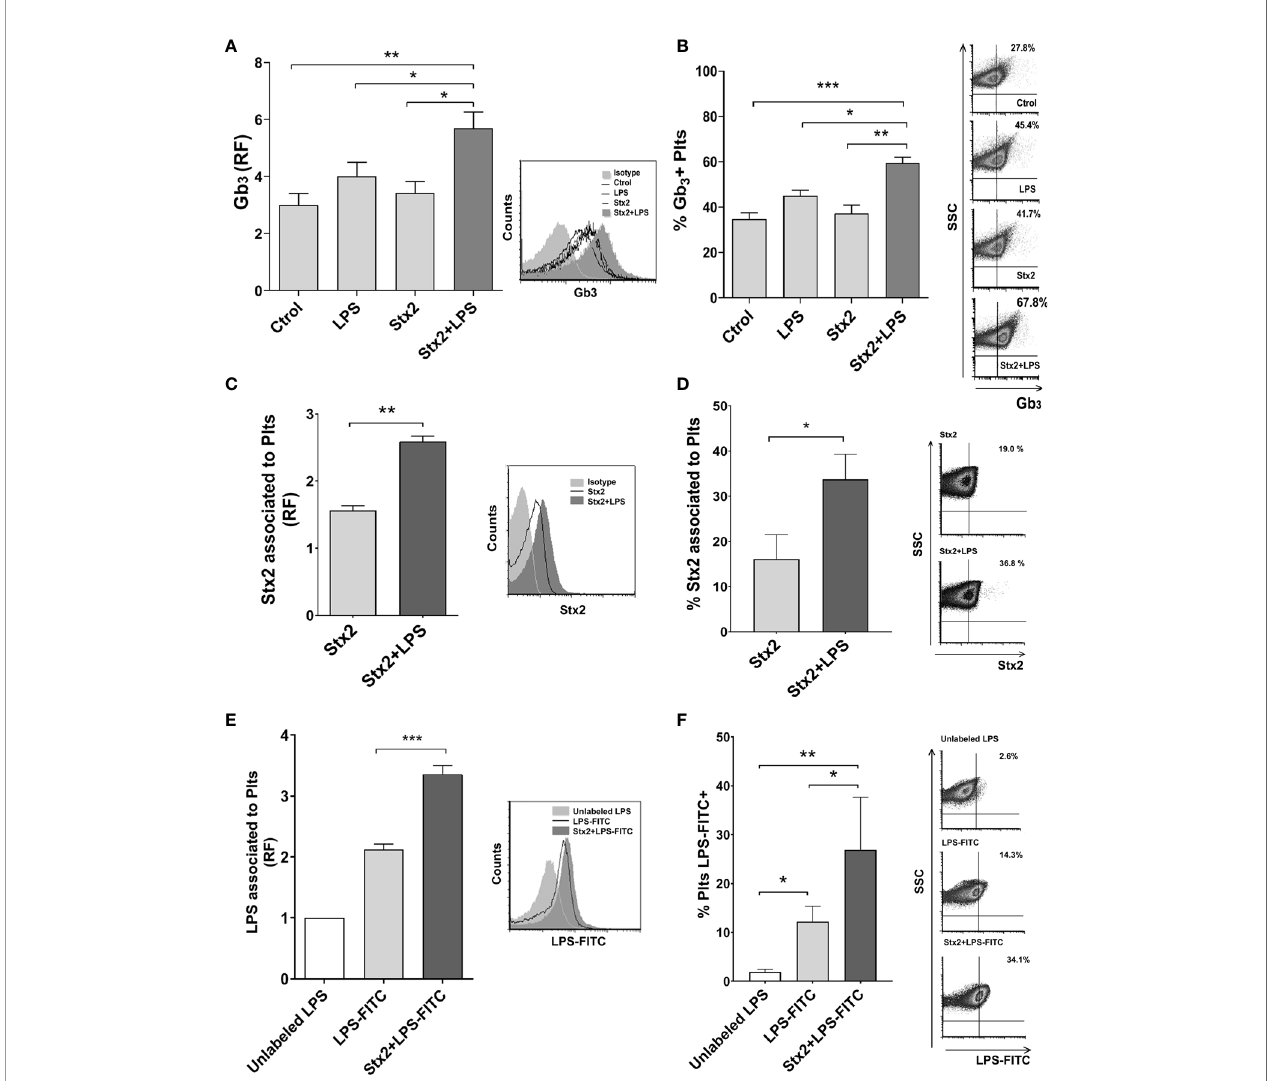
FIGURE 2 | Stx2 and LPS treatment increased Gb 3 expression and binding of Stx2 and LPS to Plts. Isolated Plts were left untreated (Ctrol) or treated with Stx2 (20 ng ml − 1 ) for 20 min before addition or not of LPS (0.3 µg ml − 1 ) for another 20 min (LPS or Stx2+LPS). Evaluation of Gb 3 expression (A) and the percentage (%) of Gb 3 expressing Plts (B) was performed by fl ow cytometry analysis. (A) Gb 3 expression was expressed as the relative fl uorescence (RF) of the mean fl uorescence intensity (MFI) obtained on treated samples compared to isotype control. Histogram plots from one representative experiment are presented (right). (n = 4). (B) Percentage (%) of Gb 3 expressing Plts. Density plots from one representative experiment are presented (right). (n = 4). (C) Stx2 association to Plts was evaluated on Plts treated with 100 ng ml − 1 Stx2 for 5 min before adding LPS (0.3 µg ml − 1 ) for another 20 min (Stx2 or Stx2+LPS). Stx2 binding was revealed using a speci fi c anti-Stx antibody and